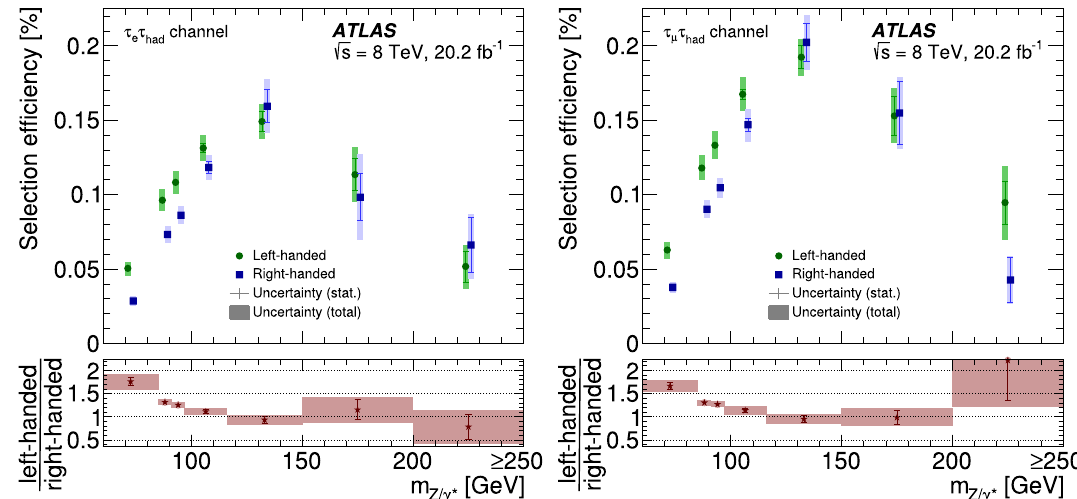
Fig. 4 Selection efficiency for signal events in the τ e – τ had (left) and τ μ – τ had (right) channels as a function of m Z /γ ∗ . No requirement is placed on the τ decay modes at stable-particle level. The statistical and